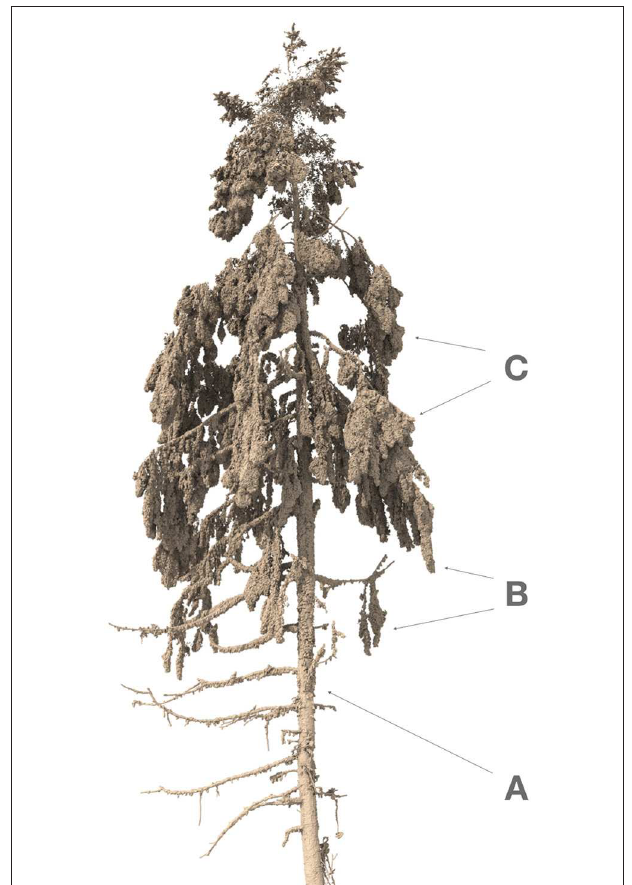
FIGURE 3 | Roosting clusters of monarch butterflies can be classified into three types based on the features of the aggregation: (A) Type 1, tree-trunk clusters–a regular pattern of clustering on the surface of the tree trunk which allows easy survey and modeling to assess the number of butterflies; (B) Type 2, distal branch clusters–a dense mass of butterflies is clustered on a distal branch that is visible from multiple directions; (C) Type 3, canopy clusters–a very dense mass of butterflies is clustered on several branches that occlude each other and the interior of the tree to form an opaque cluster/mass that is difficult to image three-dimensionally. See also Supplementary Video 1